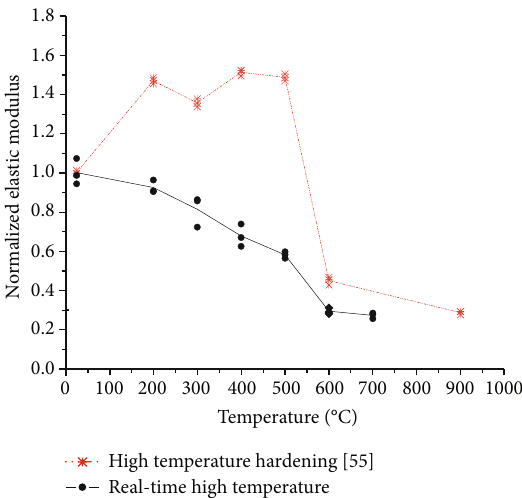
Figure 8: Normalized elastic modulus versus test temperature curves for granite at real-time high temperature and granite after high-temperature